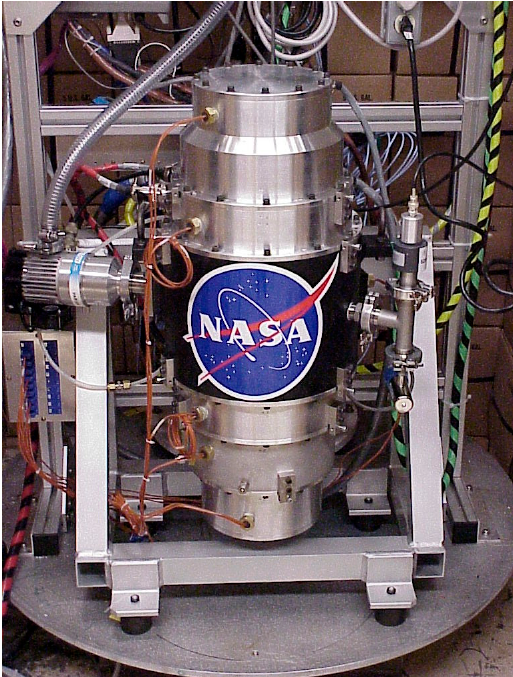
Figure 13. Image of the flywheel module designed by NASA for the G2 module. Flywheel energy storage gained popularity when NASA implemented them as a primary energy source for space missions [123]. At the NASA Glenn Research Center in the United States, a development flywheel test facility center was built. Several notable advancements in flywheel energy storage technology have been made using this facility center, and control algorithms have been optimized. The NASA Glenn Research Center envisions a complete replacement of battery-based energy storage systems with a flywheel energy storage system in the International Space Station. Due to its long cycle life and highly efficient operation at a wide range of temperatures and higher depth of discharge, the flywheel energy storage system is ideal for space transport applications. Currently employed flywheel energy storage systems by US Flywheel Systems and other organi- zations can deliver operations of efficiencies of 93%, operational speed of 110,000 rpm, and above 11.9 kW/kg [174]. While hybrid vehicles are paving the way for the future of road transportation. Engineers have recognized the need for an alternative energy storage system to the currently implemented nickel–metal hydride battery. Figure 14 is a top-down illustration of the GT3 R Hybrid’s powertrain [125]. The components in red are the flywheel hybrid system, power electronics, and the two electric motor/generator